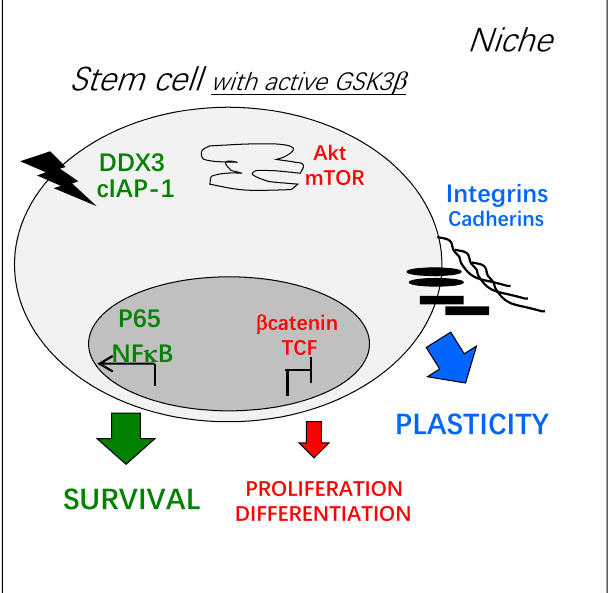
Figure 2. Key cellular functions potentially regulated by active GSK3 β in adult stem cells: Survival (green) and plasticity (blue) are promoted and metabolism/proliferation/differentiation (red) are decreased. Depending on the environment, signal transduction at the plasma membrane can trigger GSK3 activation, by the inhibition of its kinase ‐ dependent phosphorylation or the activation of its phosphatase ‐ dependent de ‐ phosphorylation, for example [1]. Inside the cell, active GSK3 can be found in different molecular complexes and its trafficking between them is poorly known. These pools of GSK3 can be independently activated or inhibited and little is known on their coordinated activation.